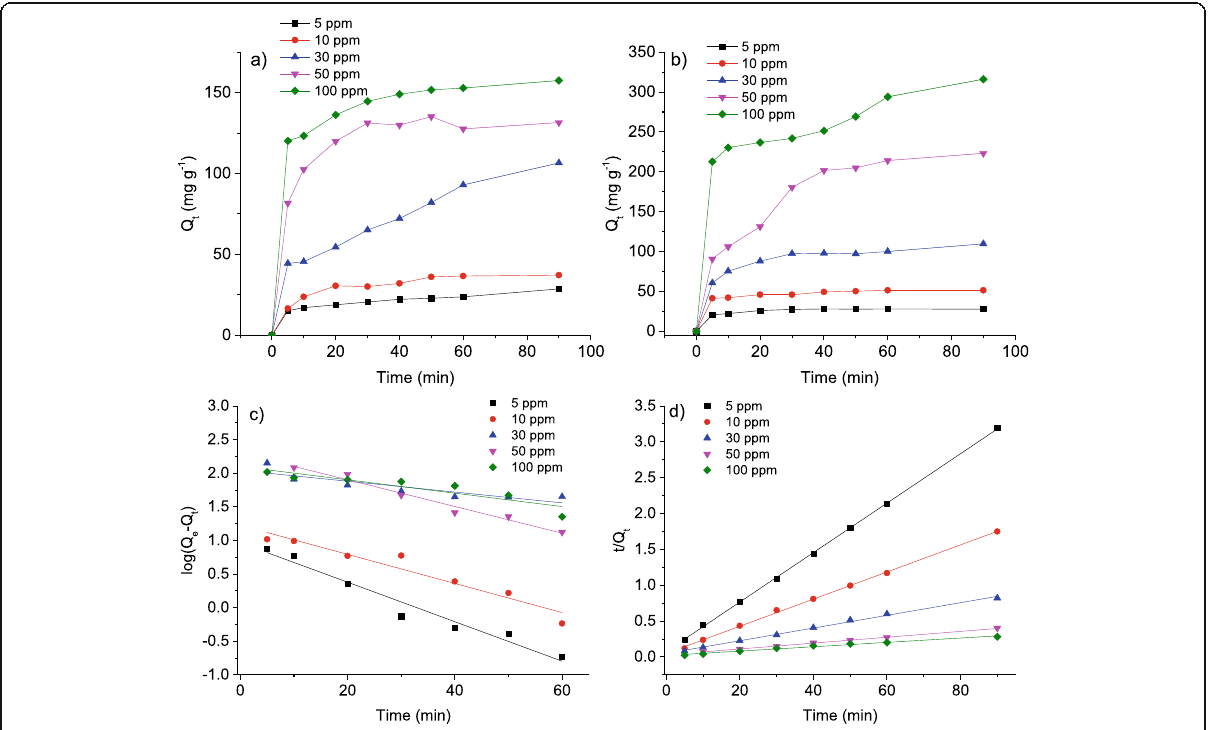
Fig. 8 Kinetics plot of a CCF and b DCCF and pseudo c first and d second order fitting of data of doped sample